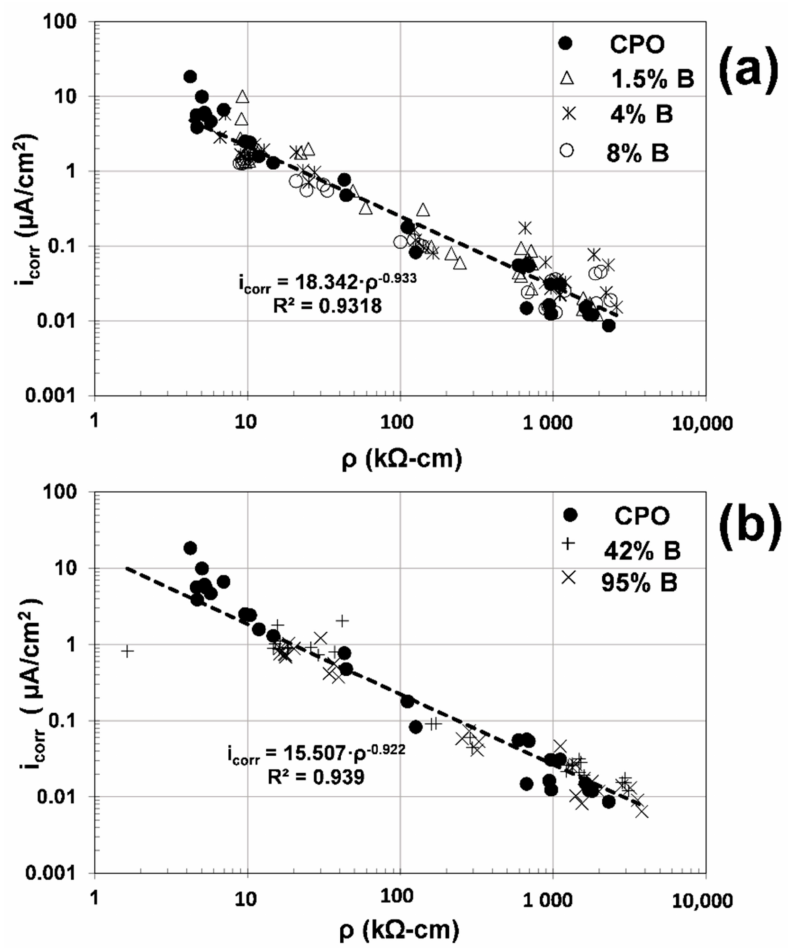
Figure 9. Composite plots of the electrochemical parameters of electrical resistivity of the mortar ( ρ ) and i corr for: ( a ) control vs. low OFI mucilage concentration; ( b ) control vs. high OFI mucilage concentration.